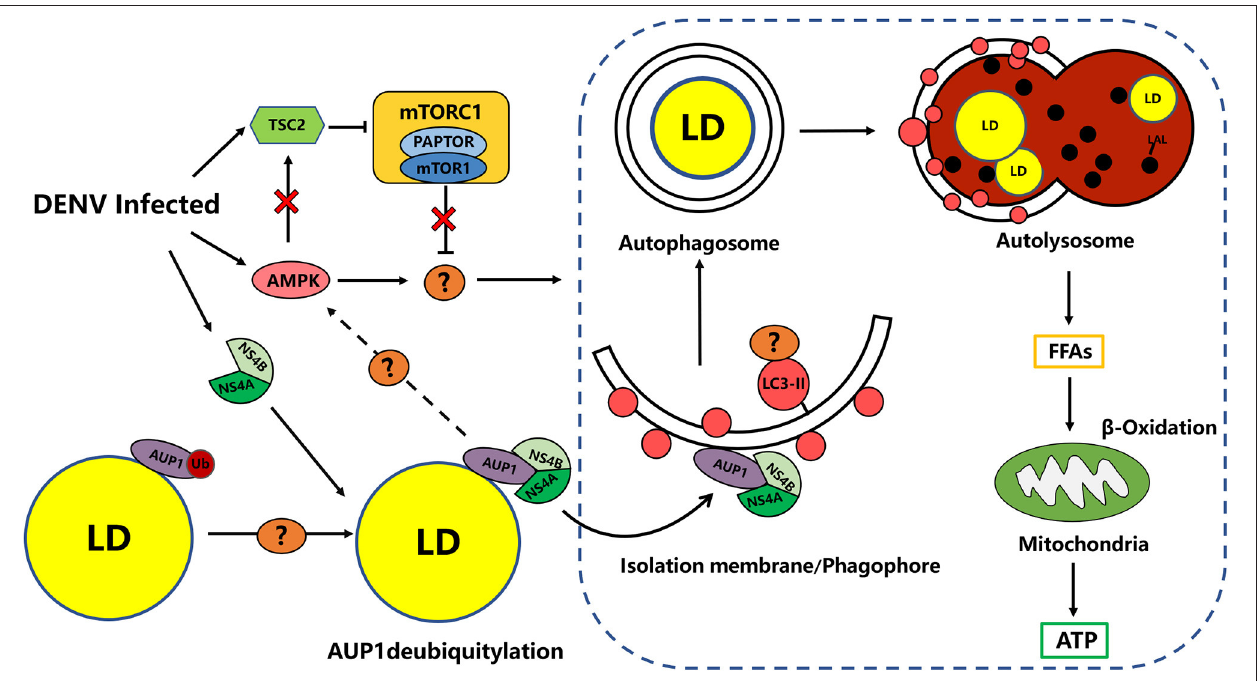
FIGURE 2 | DENV-induced Lipophagy depletes LDs to provides energy for virus replication. DENV infection activates and requires AMPK signaling as well as AMPK-independent inhibition of mTORC1 activity to target unknown candidate to induce proviral lipophagy. DENV infection induces the deubiquitylation of AUP1 by an unknown mechanism. DENV NS4A/4B binds the deubiquitylated AUP1 and relocalizes it to the autophagy initiation. AUP1 relocalization may trigger lipophagy through the AMPK/mTOR pathway. Phagophores may be targeted to LDs through unknown selective autophagy receptors. DENV upregulate lipophagy dependent on the AUP1 lysophospholipid acyltransferase activity to release FFAs from LDs, for subsequent catabolic processing via β -oxidation (Lin et al.,